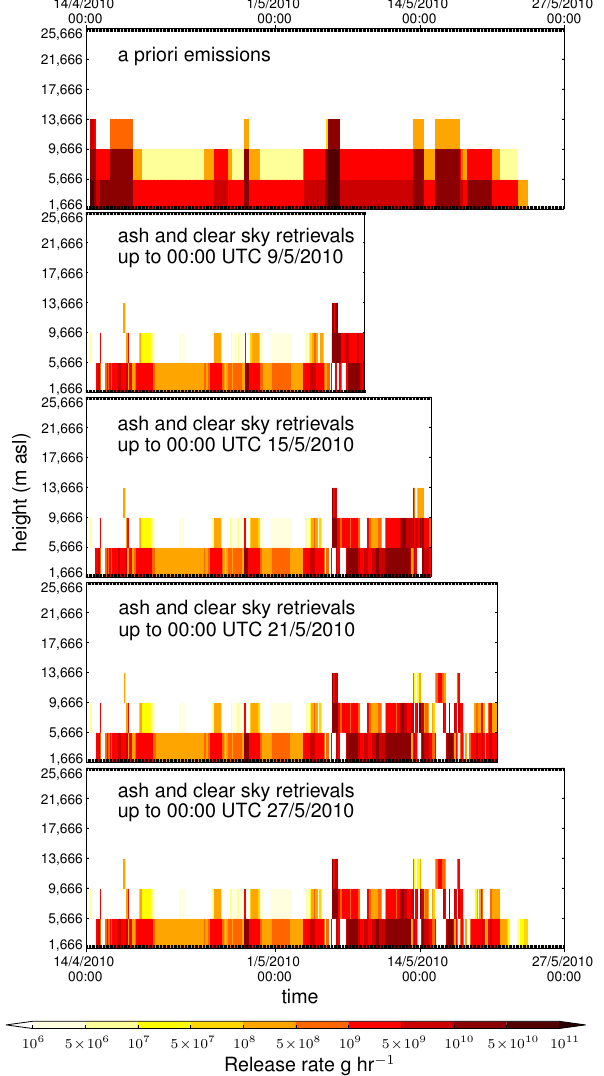
Figure 4. As Figure 3 but using ash and clear sky satellite